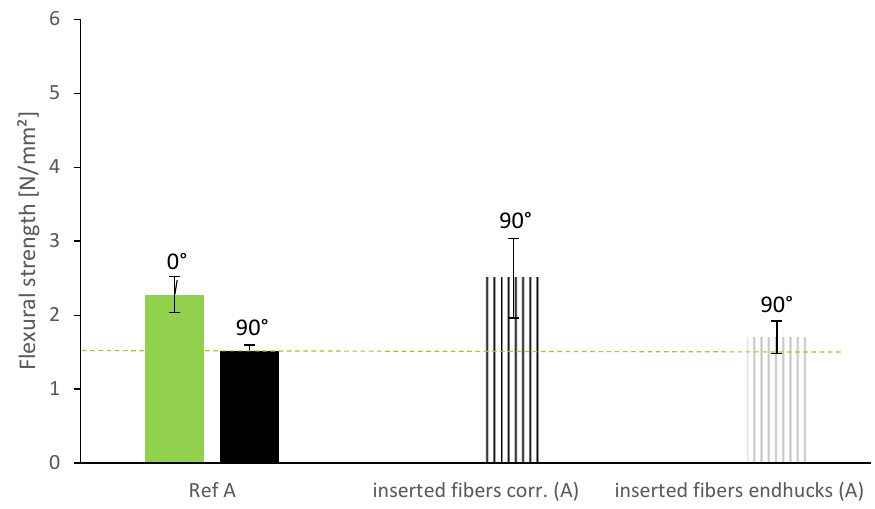
Figure 9. Flexural strength of specimen with vertically inserted fiber reinforcement.